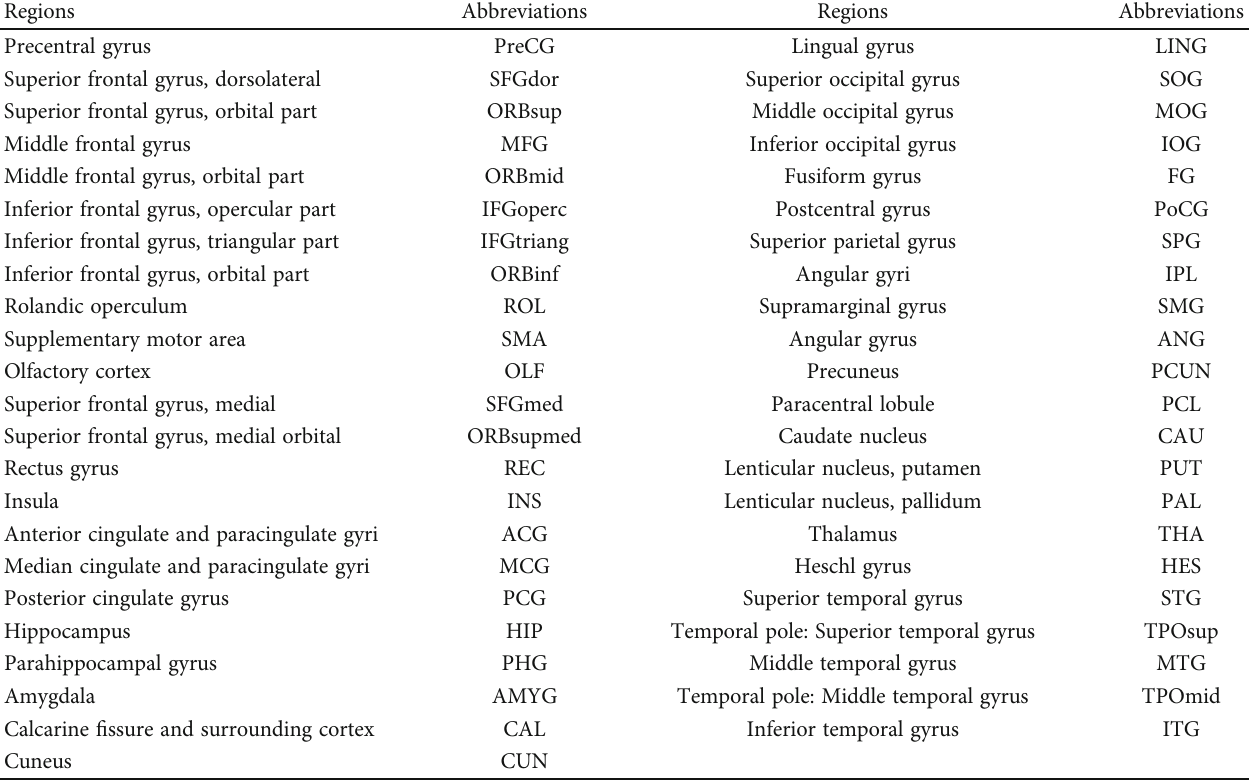
Table 2: Cortical and subcortical regions of interest de fi ned in this study.